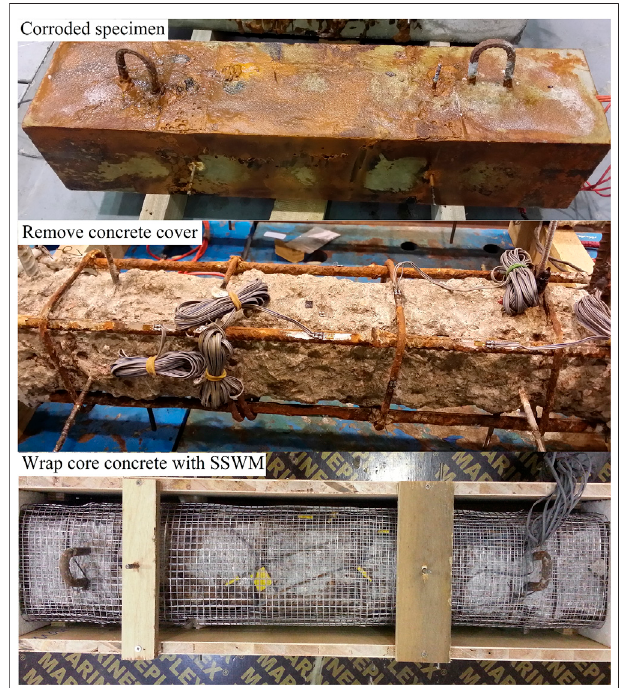
FIGURE 3 | Strengthening